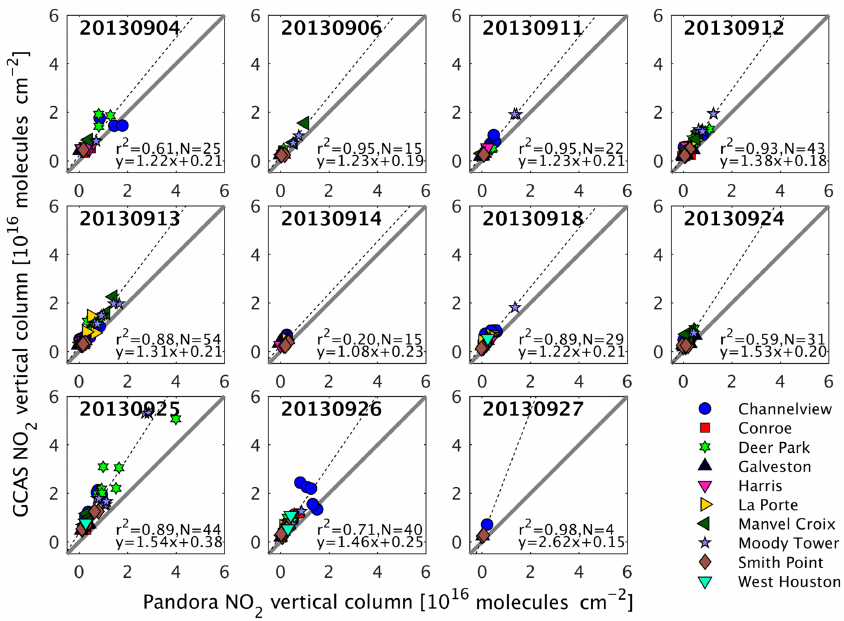
Figure 8. Pandora direct-sun NO 2 tropospheric columns vs. GCAS NO 2 tropospheric columns by day for cloud-free observations over Houston during DISCOVER-AQ Texas 2013. The Pandora columns are the total NO 2 columns measured by Pandora minus the colocated modeled stratospheric NO 2 columns used in the GCAS analysis. All correlations are statistically significant at the p < 0 . 001 level except for those of 14 ( p = 0 . 09) and 27 ( p = 0 . 01) September. The solid line represents the 1:1 ratio. The dotted line represents the reduced major axis linear regression.